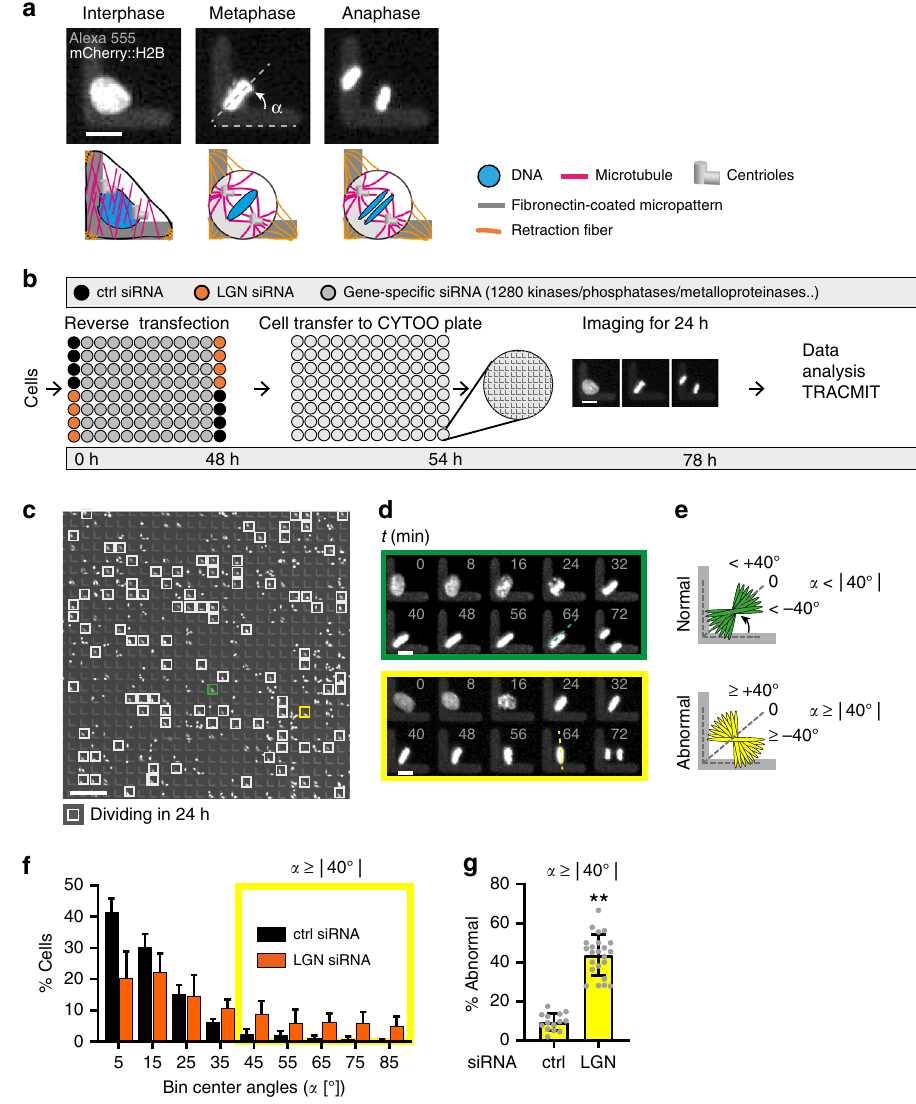
Fig. 1 Live imaging functional genomic assay for spindle positioning in human cells. a HeLa cell expressing mCherry::H2B grown on L-shaped micropattern coated with fi bronectin-Alexa 555. Top: raw time-lapse microscopy data; bottom: corresponding schematics. Upon cell rounding in mitosis, the metaphase plate is positioned with an angle α of ~45° (dashed line) with respect to the arms of the L. Scale bar: 10 µ m. b Screening pipeline. Time in hours is indicated underneath. Cells (HeLa, mCherry::H2B) are seeded in small interfering RNA (siRNA)-containing 96-well plates. After incubation for 48 h, cells are transferred to 96-well plates containing L-shaped micropatterns and imaged for 24 h with a frame rate of 8 min (see d ). Data analysis is performed using the ImageJ-based analysis pipeline TRACMIT. Scale bar: 10 µ m. c Example of visual fi eld from time-lapse microscopy (see b ). Gray boxes mark micropatterns containing single cells that have divided within the 24 h imaging period. Green and yellow boxes indicate cells enlarged in d . Scale bar: 150 µ m. d Green rectangle: cell dividing as expected (normal), with a metaphase angle close to the 0 reference position; yellow rectangle: cell deviating ≥ 40° from that position (abnormal spindle positioning). Time is indicated in min. Scale bar: 10 µ m. e Schematic representations corresponding to d . Upper panel: “ normal ” spindle angles (green, α < 40° from 0 position); lower panel: “ abnormal ” spindle angles (yellow, α ≥ 40° from 0 position). f Frequency distributions of metaphase angles of control (ctrl, black) and LGN (orange) siRNA-treated cells from three pilot 96-well plates containing